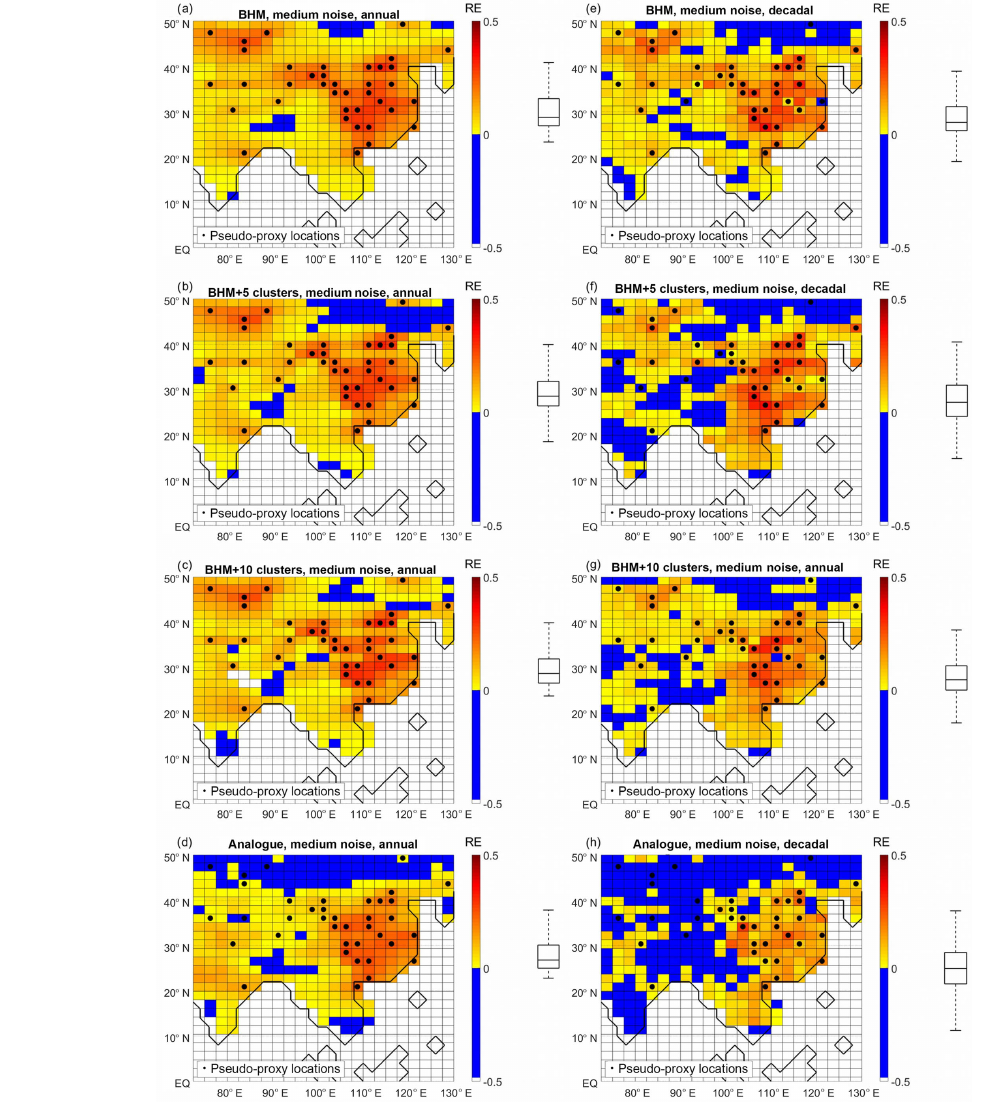
Figure 5. RE index for different reconstructions, at each grid point. (a, b, c, d) Annually resolved data. (e, f, g, h) Decadally resolved data. (a, e) BHM. (b, f) BHM + 5Clusters. (c, g) BHM + 10Clsuters. (d, h) Analogue method. The boxplots (indicating median, 25% and 75% percentiles and non-outlier limits) to the right of the colour bars show the distribution of the grid-point RE index. Black dots: pseudo-proxy